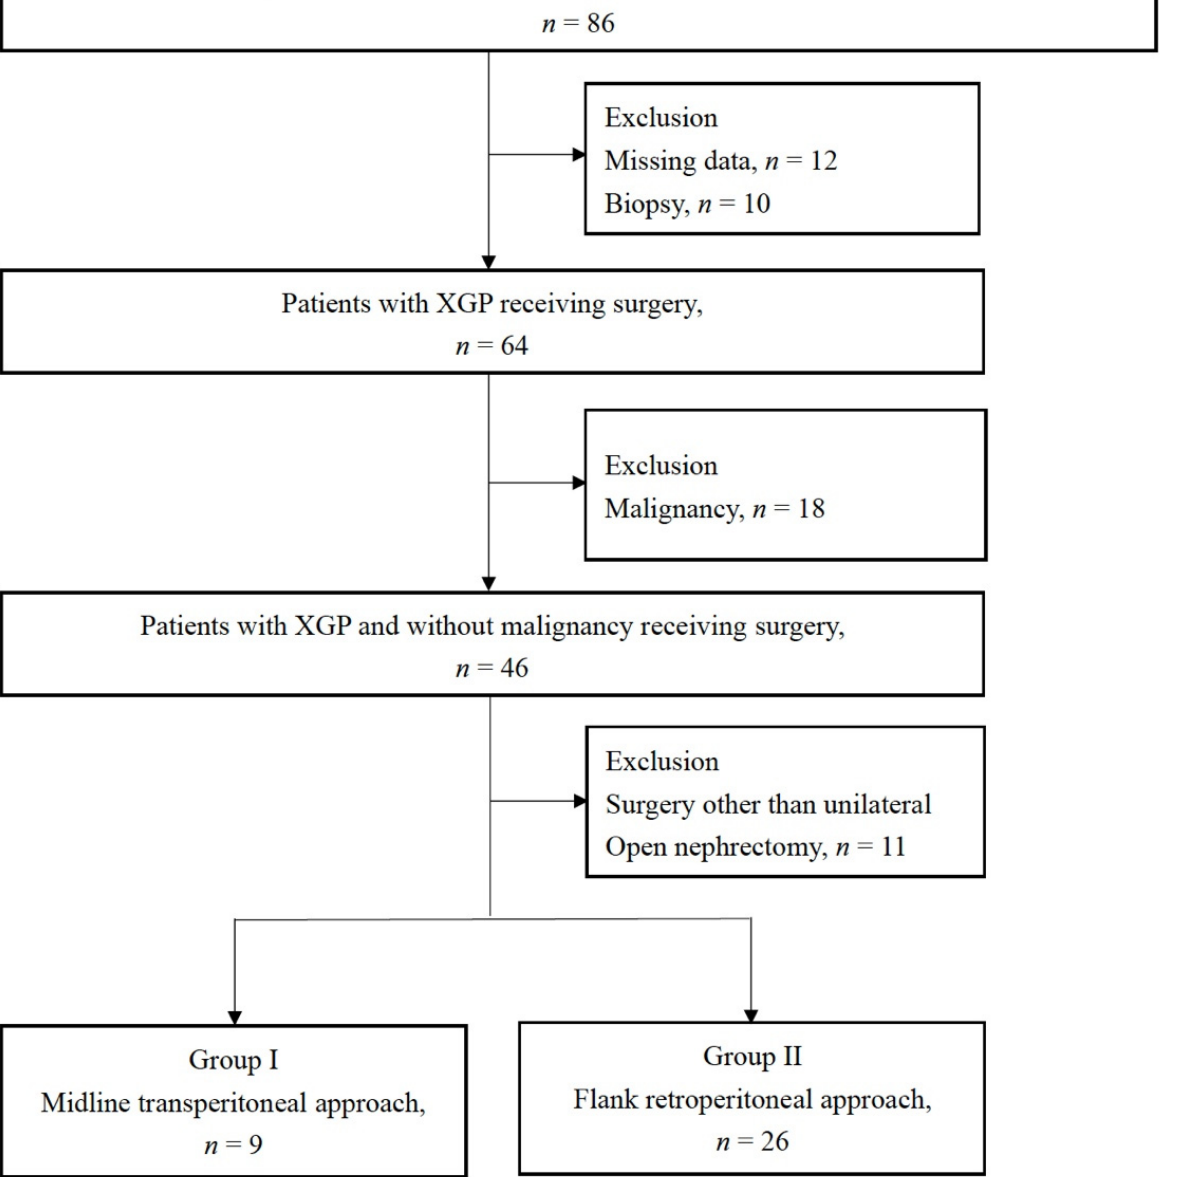
Figure 1. Flowchart of patient enrollment .